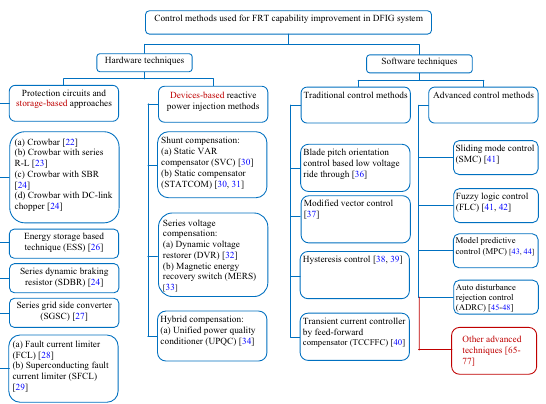
Fig. 2 Methods used to improve the FRT capability in the DFIG